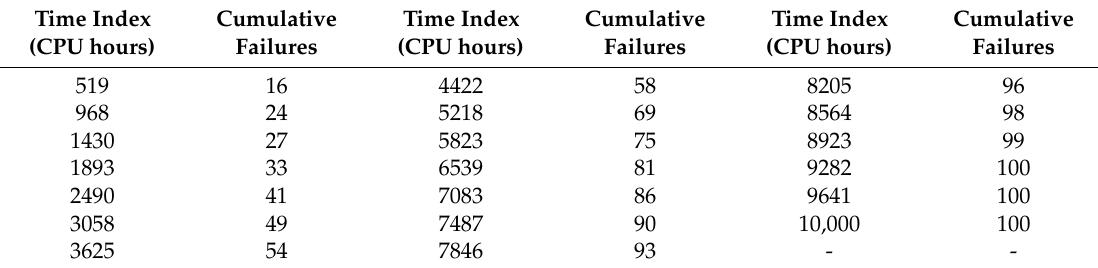
Table 4. DS3: Tandom Computers (TDC) data